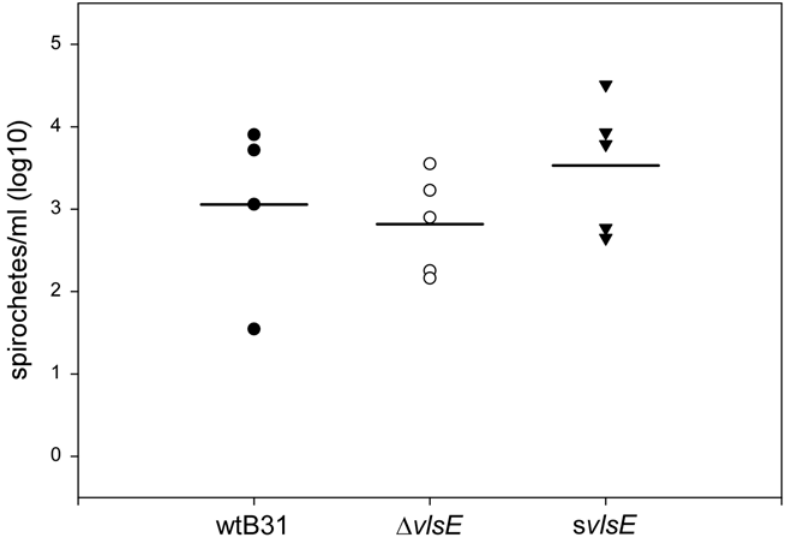
Fig 2. vls mutant clones do not show reduced spirochetemia in C3H mice. Blood was collected from saphenous and submandibular veins of C3H mice at day 7 post-infection after subcutaneous needle inoculation with B . burgdorferi clones. Isolated blood was plated in semi-solid BSK by limiting dilution, and colony-forming units (CFU) were enumerated for each strain. CFU/ml blood is shown for each mouse infected with wtB31 (closed circles), Δ vlsE (open circles), and s vlsE (closed triangles), as well as mean CFU/ml for each group (horizontal